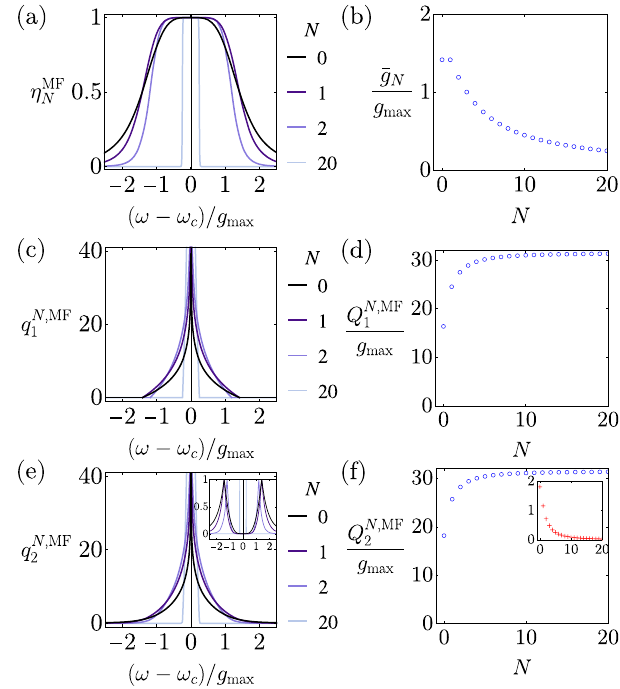
Fig. 2 | Diagrams for N -stage quantum transducers with maximally fl at con- versionef fi ciency.a Maximally fl atef fi ciencyfunction η MF N ½ ω (cid:2) fordifferent N . b The mean coupling (cid:2) g N as a function of N . c The discrete-time one-way pure-loss capa- city, q N ,MF 1 ½ ω (cid:2) , for different N . d The continuous-time one-way pure-loss capacity, Q N ,MF 1 , as a function of N . e The discrete-time two-way pure-loss capacity, q N ,MF 2 ½ ω (cid:2)